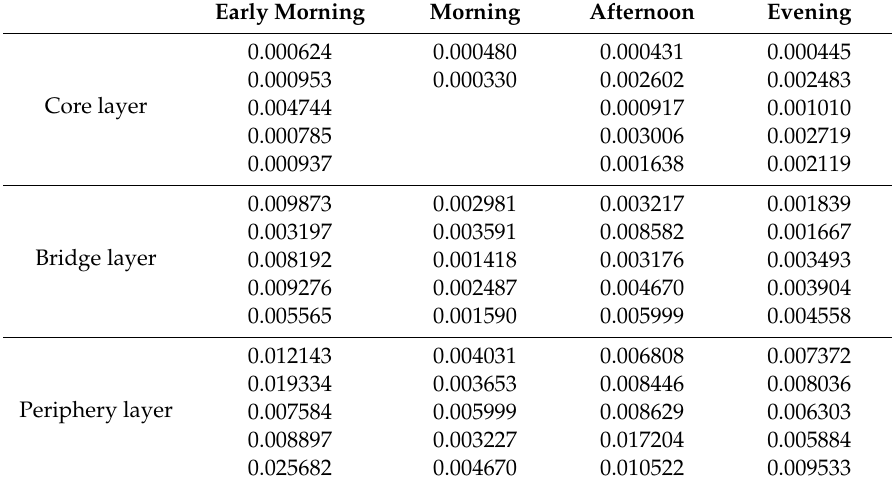
Table 6. Top five places with the largest coreness in the core, bridge, and periphery layers on weekends. Value is the cluster coe ffi cient of a